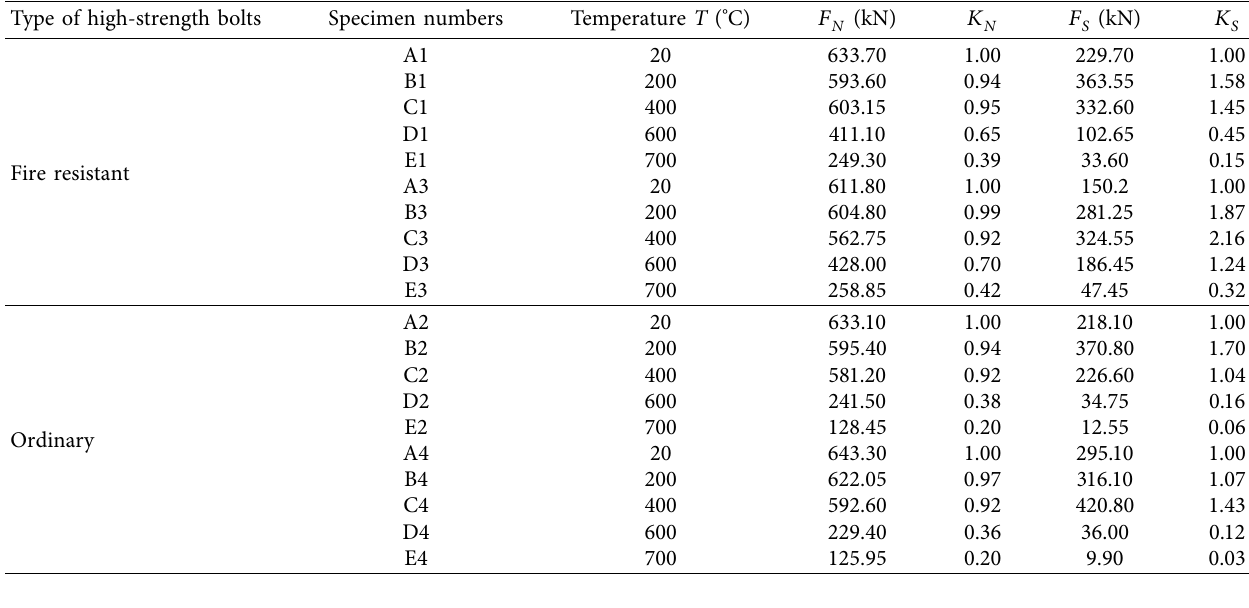
Table 5: Experimental results of specimen bearing capacity. Type of high-strength bolts